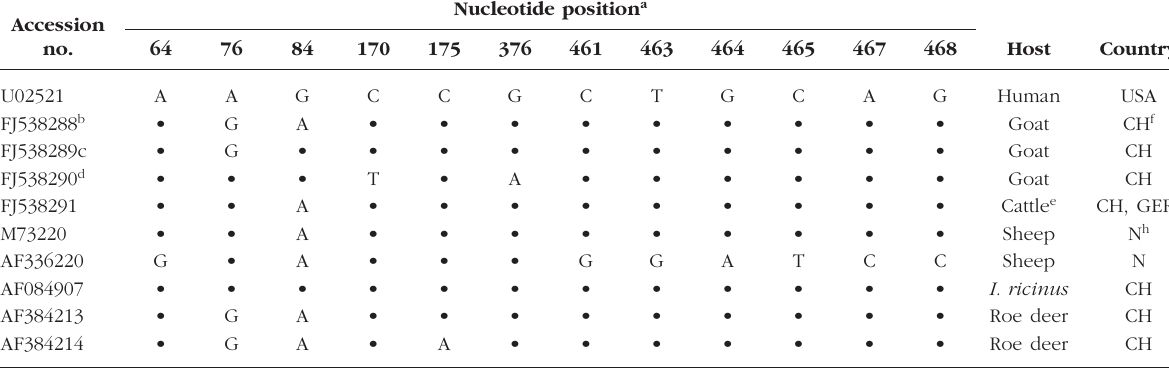
Table II. – Comparison of the 526bp sequences of the 16S rRNA gene of Anaplasma phagocytophilum from this study with selected sequences from the GenBank